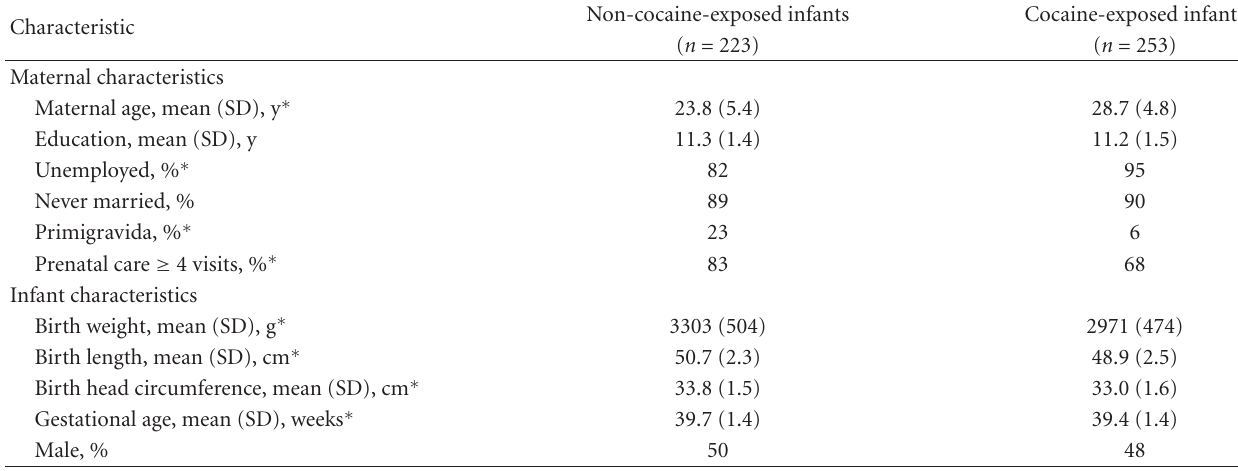
Table 1: Characteristics of infants with and without prenatal cocaine exposure and their mothers at enrollment in the Miami Prenatal Cocaine Study.